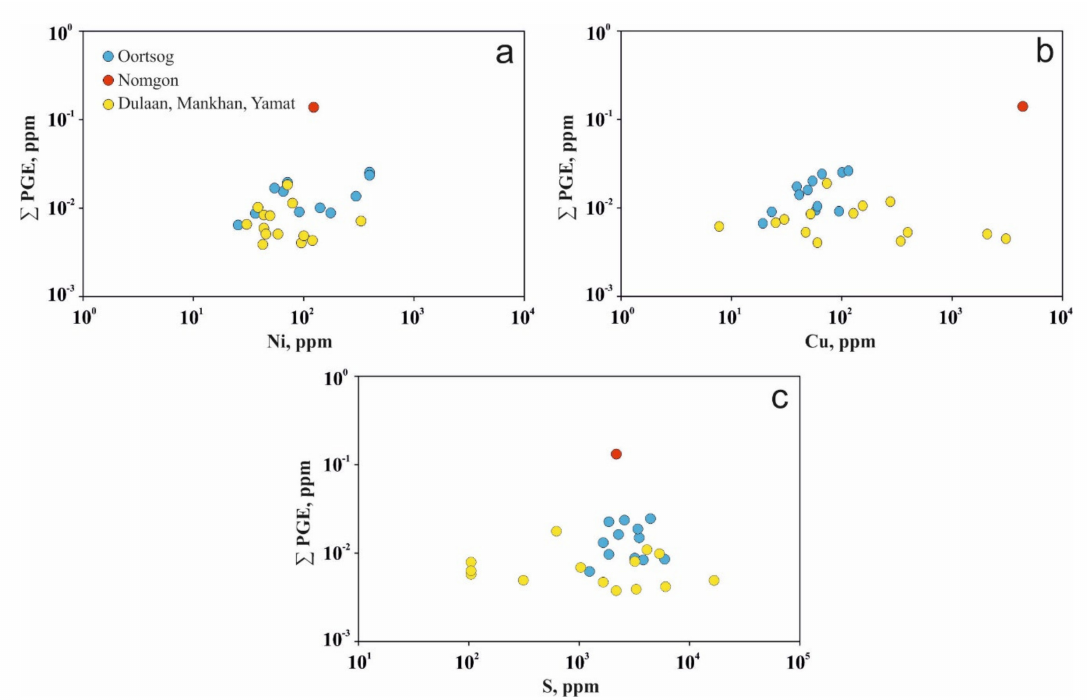
Figure 9. Correlation of Σ PGE vs. Ni ( a ), Cu ( b ), S ( c ) of the studied